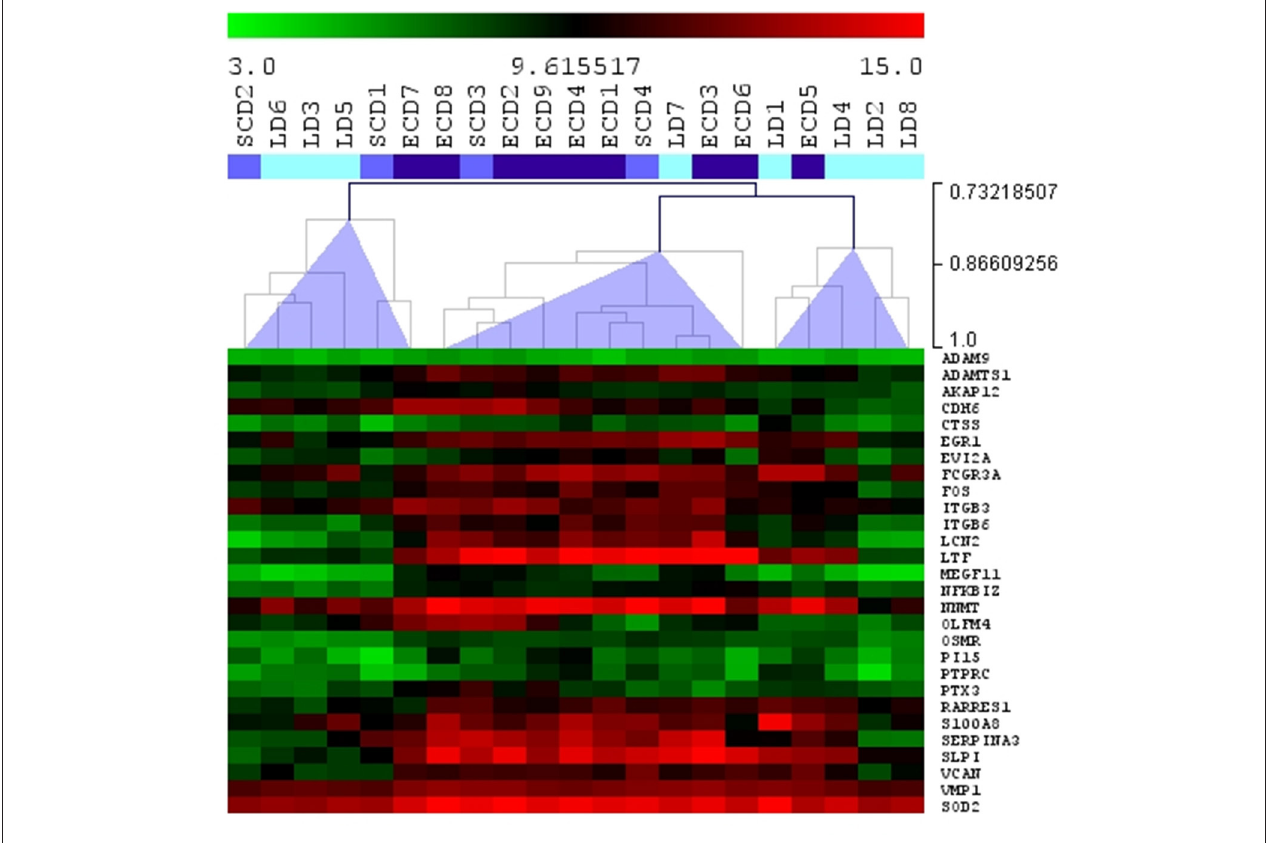
FIGURE 3 | Hierarchical clustering (Spearman rank correlation) for 28 injury-repaired associated transcripts related to acute kidney injury measured in early indication biopsies with borderline changes in different donor categories using Agilent microarray. Light blue: LD, living donor; intermediate blue: SCD, standard criteria donor; dark blue: ECD, expanded criteria donor. Most acute kidney injury transcripts were increased in the second cluster, formed in 70% by grafts from ECD donors.